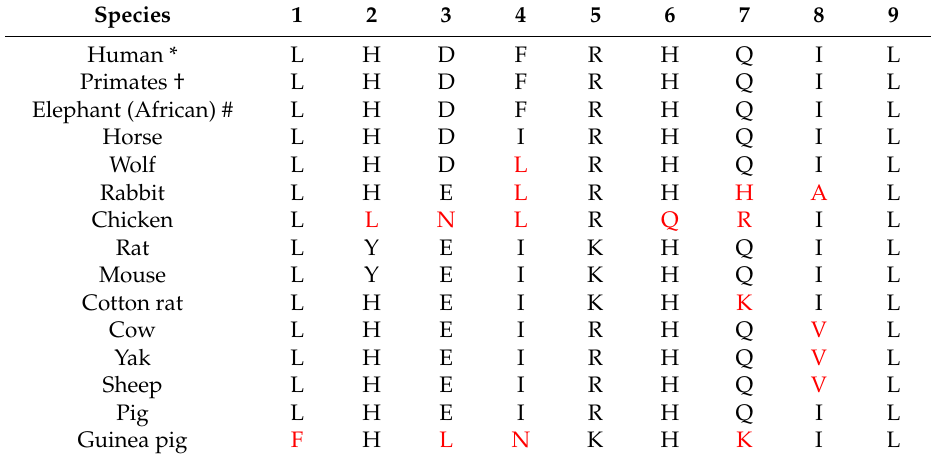
Table 3. Amino acids at the 9 amino acid positions in SP-A between 111-119 for various mammalian and 1 avian species.